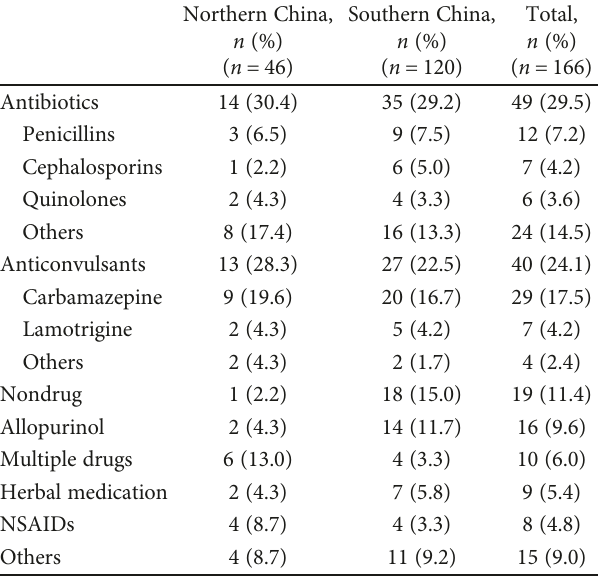
Table 3: Comparison of the common drug causality between northern and southern